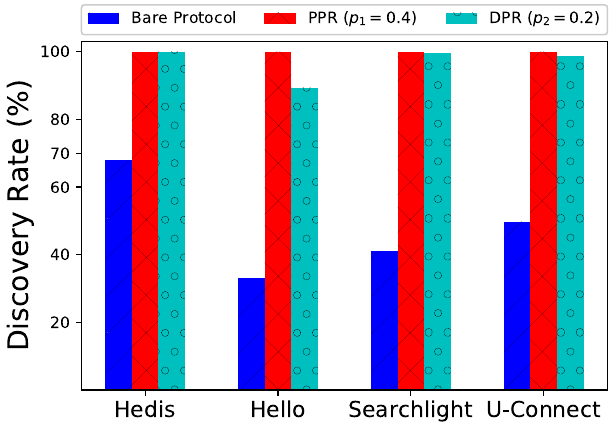
Figure 1. Spear greatly improves discovery rates for four notable protocols. Discovery rate for each protocol is defined as the number of discovered neighbors divided by all actual neighbors. Bare protocols mean they do not run in